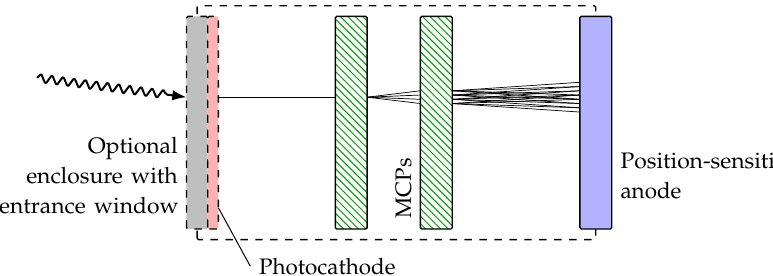
Figure 1. Illustration of the design of a single photon counting detector. Photons impinging on the (optional) photocathode (red) or the microchannel plates (MCP) (green) release photoelectrons, which are multiplied by MCPs. The resulting charge cloud is detected using a position sensitive anode